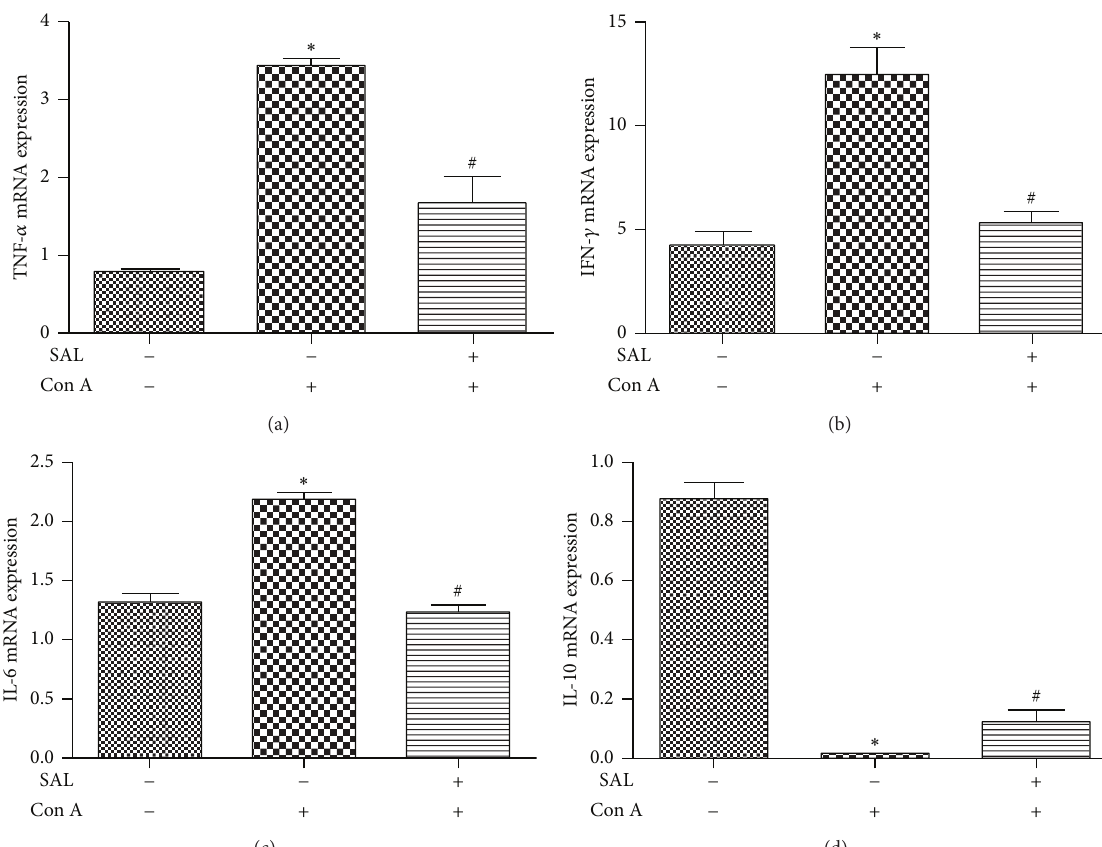
Figure 4: Intrahepatic mRNA expression of cytokines. Samples were collected 12h after intravenous Con A administration. (a)–(c) Salidroside alleviated intrahepatic mRNA expression of proinflammatory cytokines (TNF- 𝛼 , IFN- 𝛾 , and IL-6) and (d) Salidroside increased intrahepatic mRNA expression of IL-10. The data output is expressed as a fold-change of expression levels. Level of each type of mRNA from control group was normalized to a value of 1 ∗ 𝑃 < 0.01 versus control group, # 𝑃 < 0.01 versus Con A group.